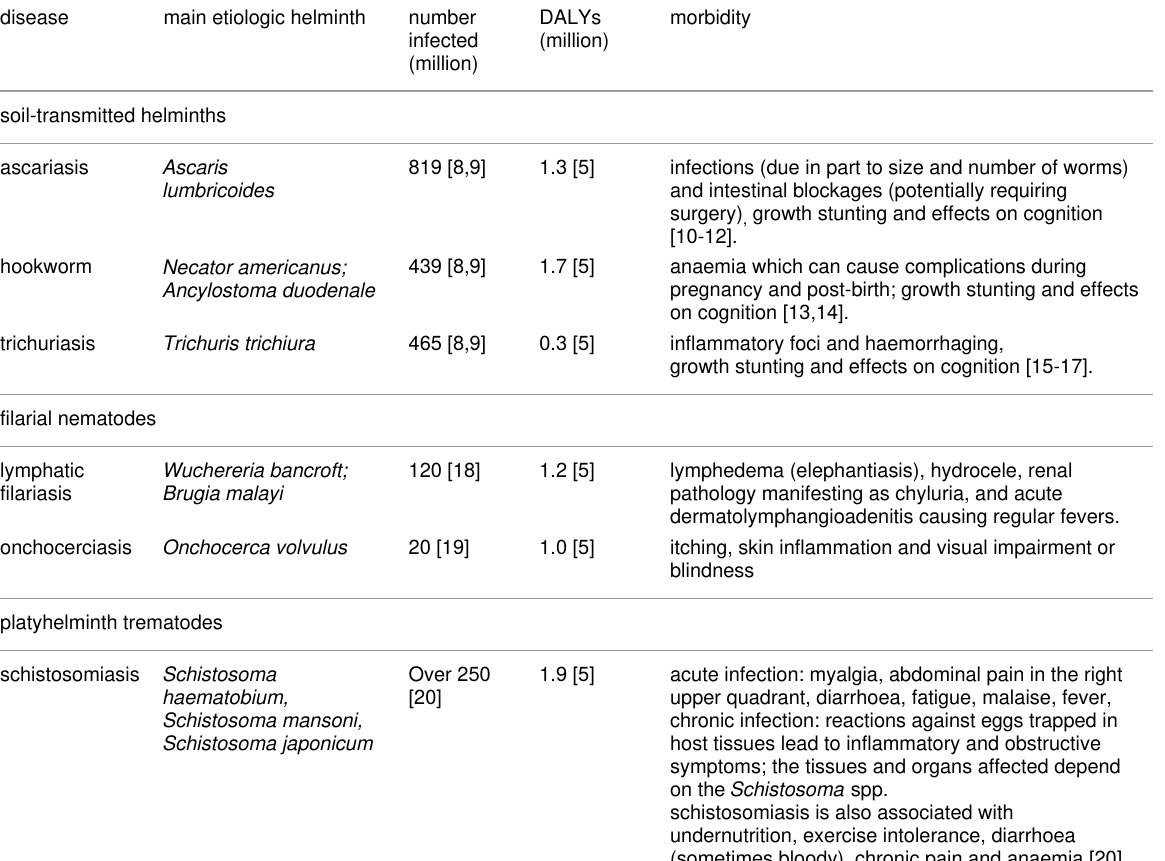
Table 1: Prevalence of and morbidity caused by major human helminth infections. DALYs are disability-adjusted life years.